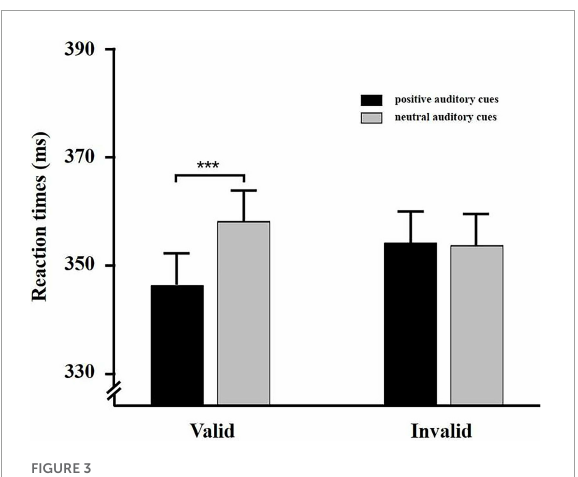
FIGURE3 Behavioral results for Experiment 3. Average reaction times to visual targets for positive and neutral auditory cues. Error bars indicate standard error (SE) of the mean. *** p <